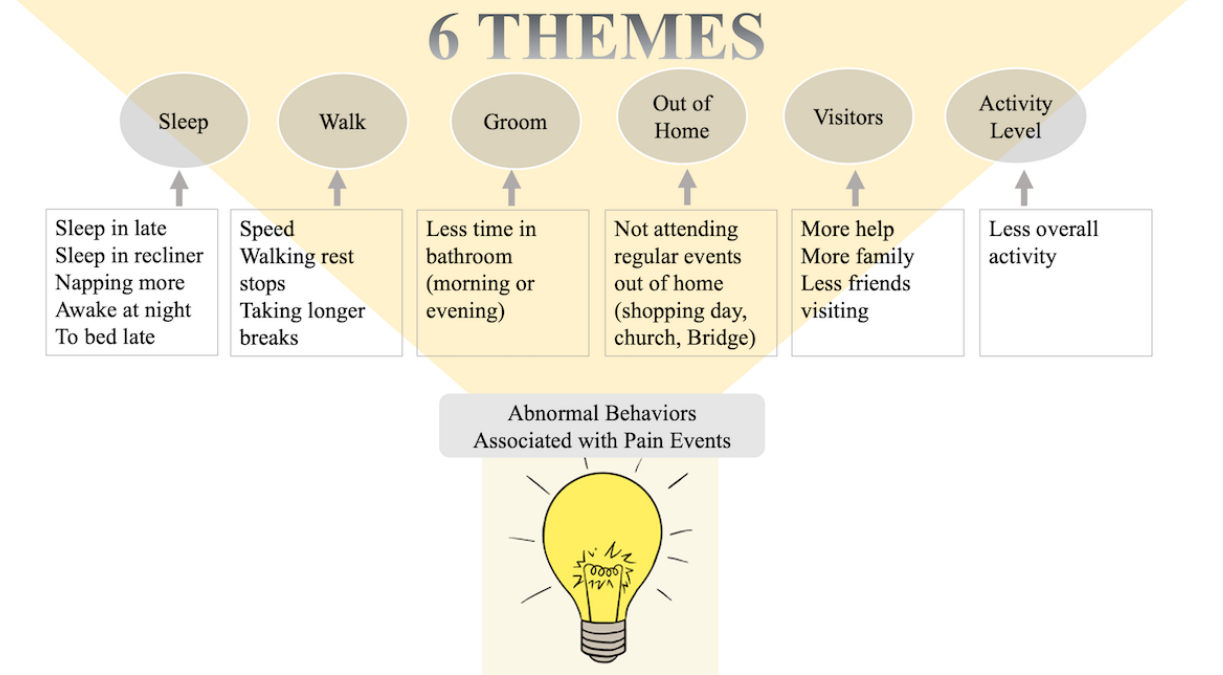
Figure 2. Abnormal pain-related behaviors observed in the sensor data, with 6 overarching